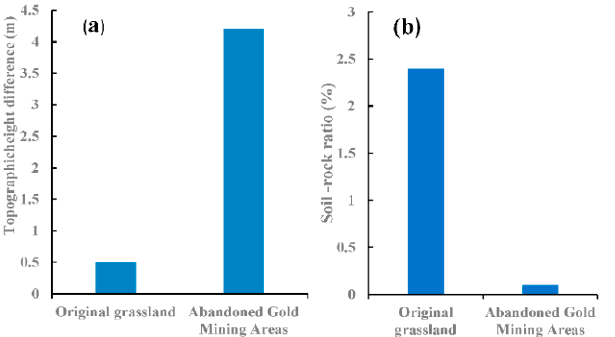
Figure 3. Topographic height difference and soil-rock ratio of original grassland and abandoned mining area. Note: ( a , b ) are subtitle of Figure. ( a ) is topographic height difference and ( b ) is the soil-rock ratio.